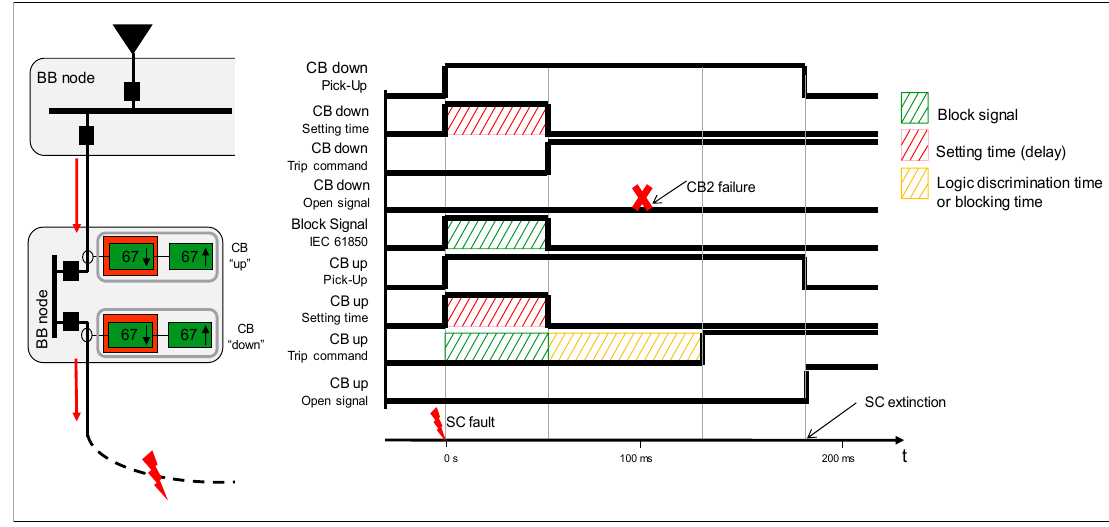
Figure 17. CB failure in ring main distribution system.